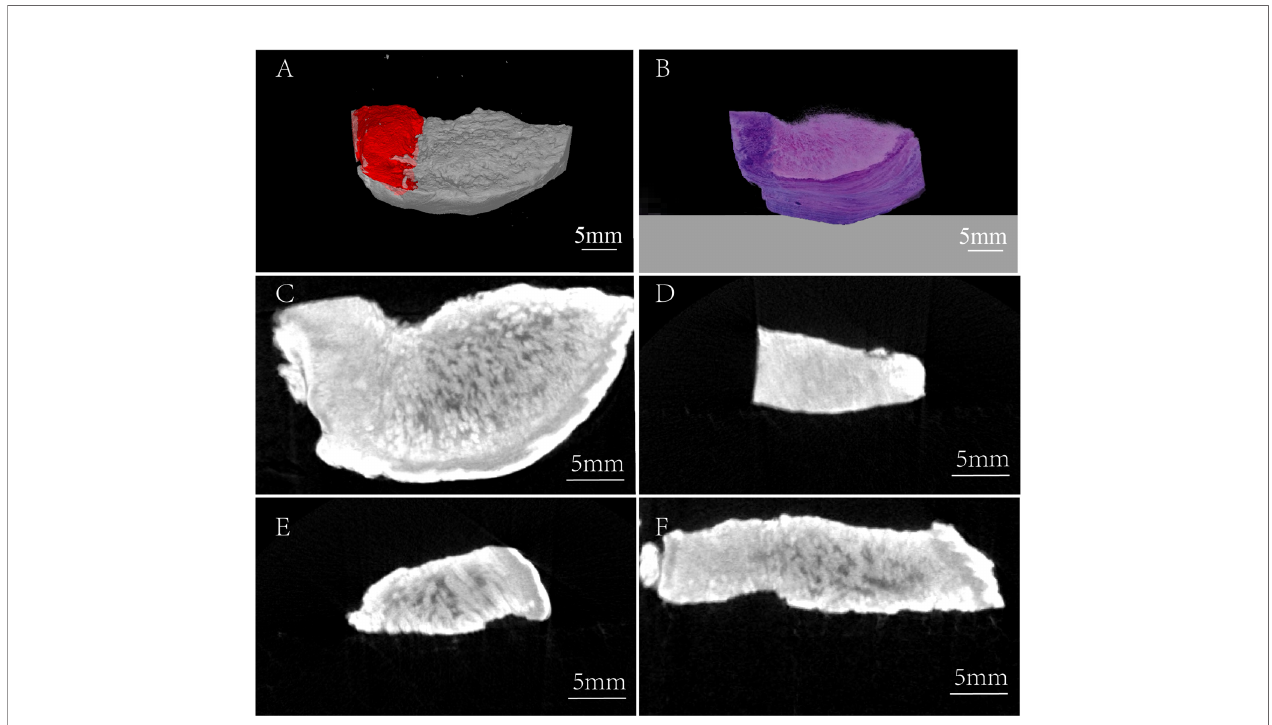
FIGURE 3 | Three-dimensional comparison between the micro-CT image and H&E staining image. (A) Micro-CT 3-D reconstruction image, red region: tumor tissue. (B) 3-D H&E staining image. (C) Horizontal view of TSCC sample. (D) Frontal view of TSCC sample (the region of tumor tissue). (E) Frontal view of TSCC sample (the region of normal tissue). (F) Axial view of TSCC